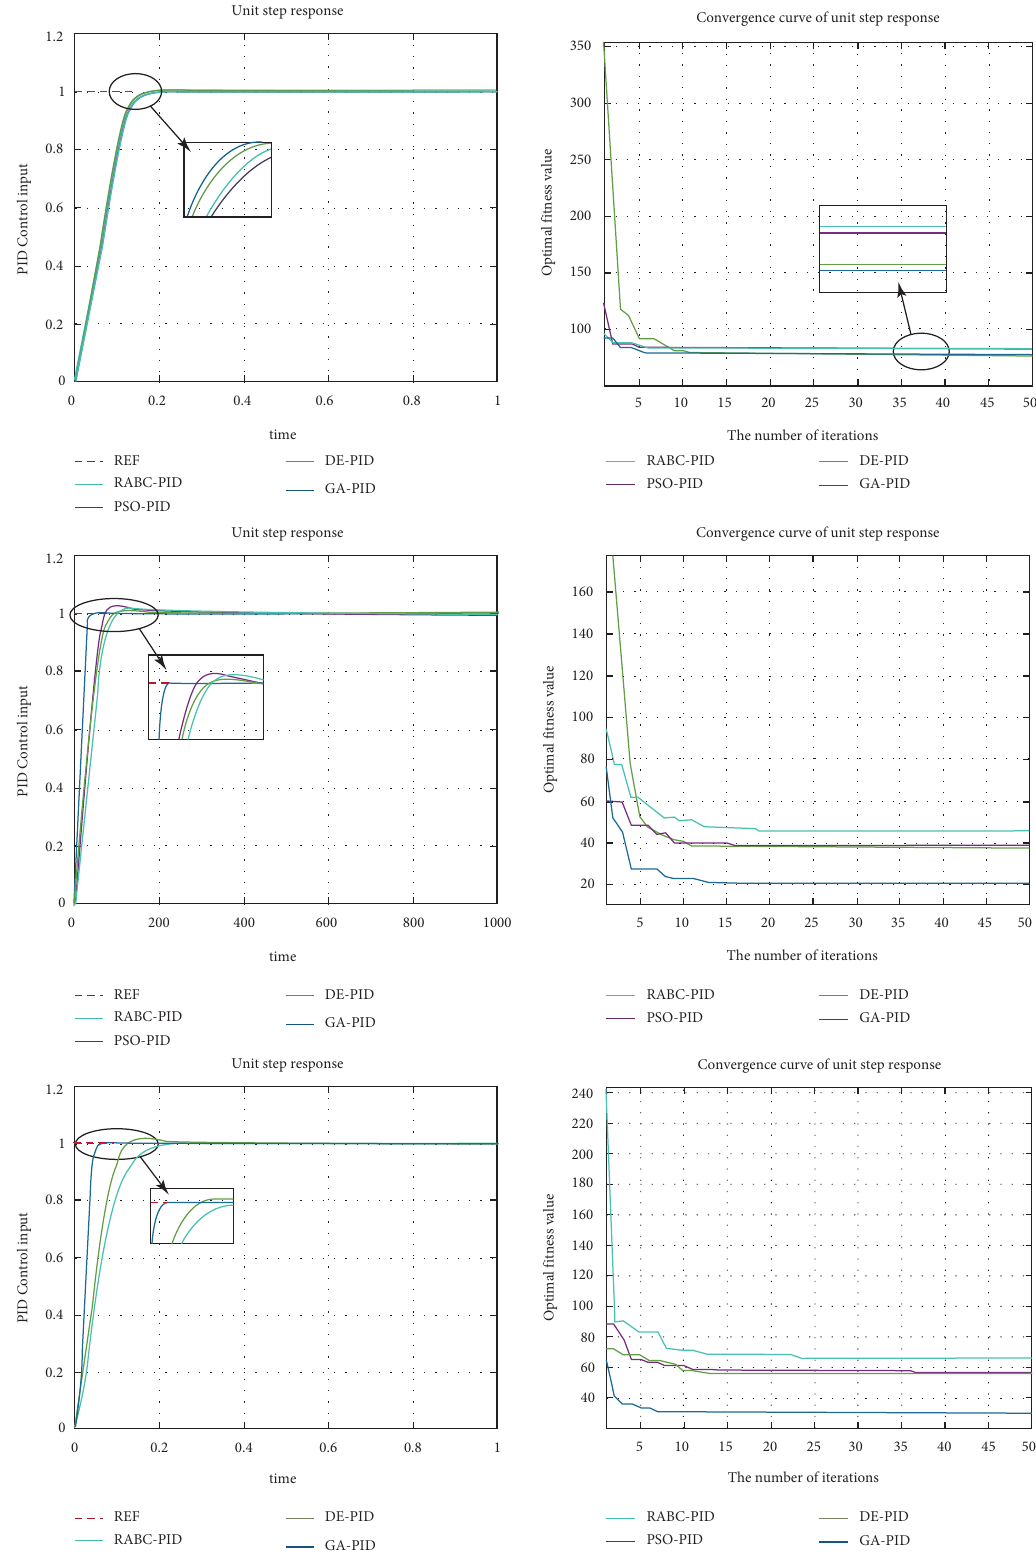
Figure 7: Unit step response curve and convergence